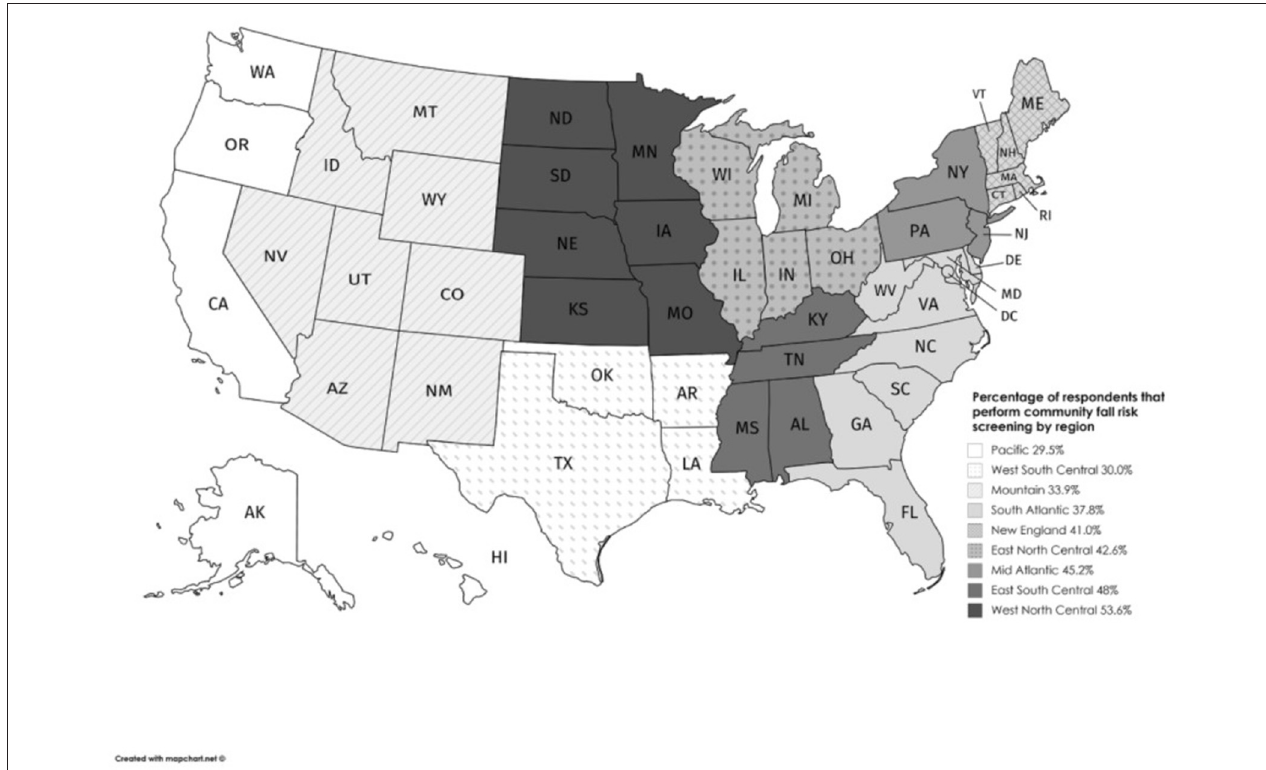
FIGURE 1 | Percentage of physical therapists conducting community fall risk screenings by region.